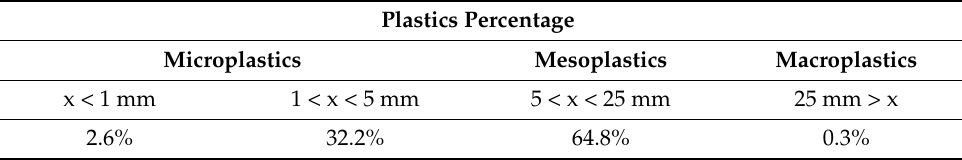
Figure 4. Frequency distribution by shapes of plastic fragments found in the stomachs of blackmouth catsharks in the five populations studied. Table 3. Percentage of the size structure of plastics divided into three size categories: microplastics, mesoplastics, and